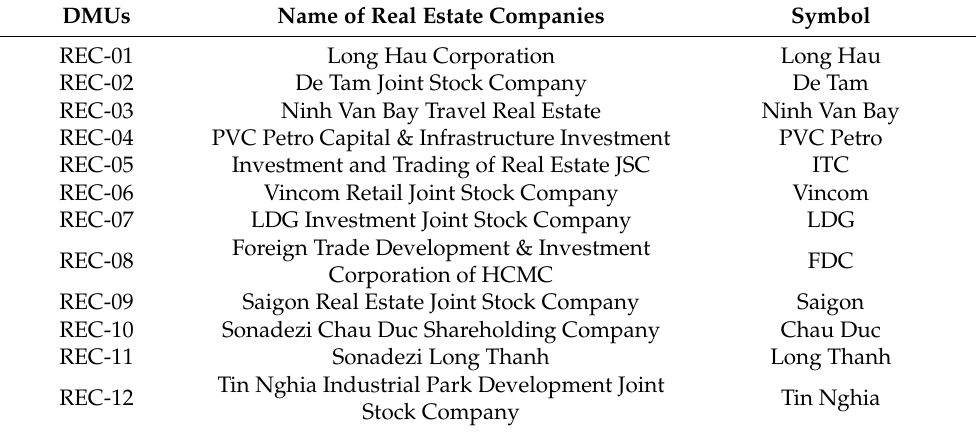
Table 1. DMUs list.